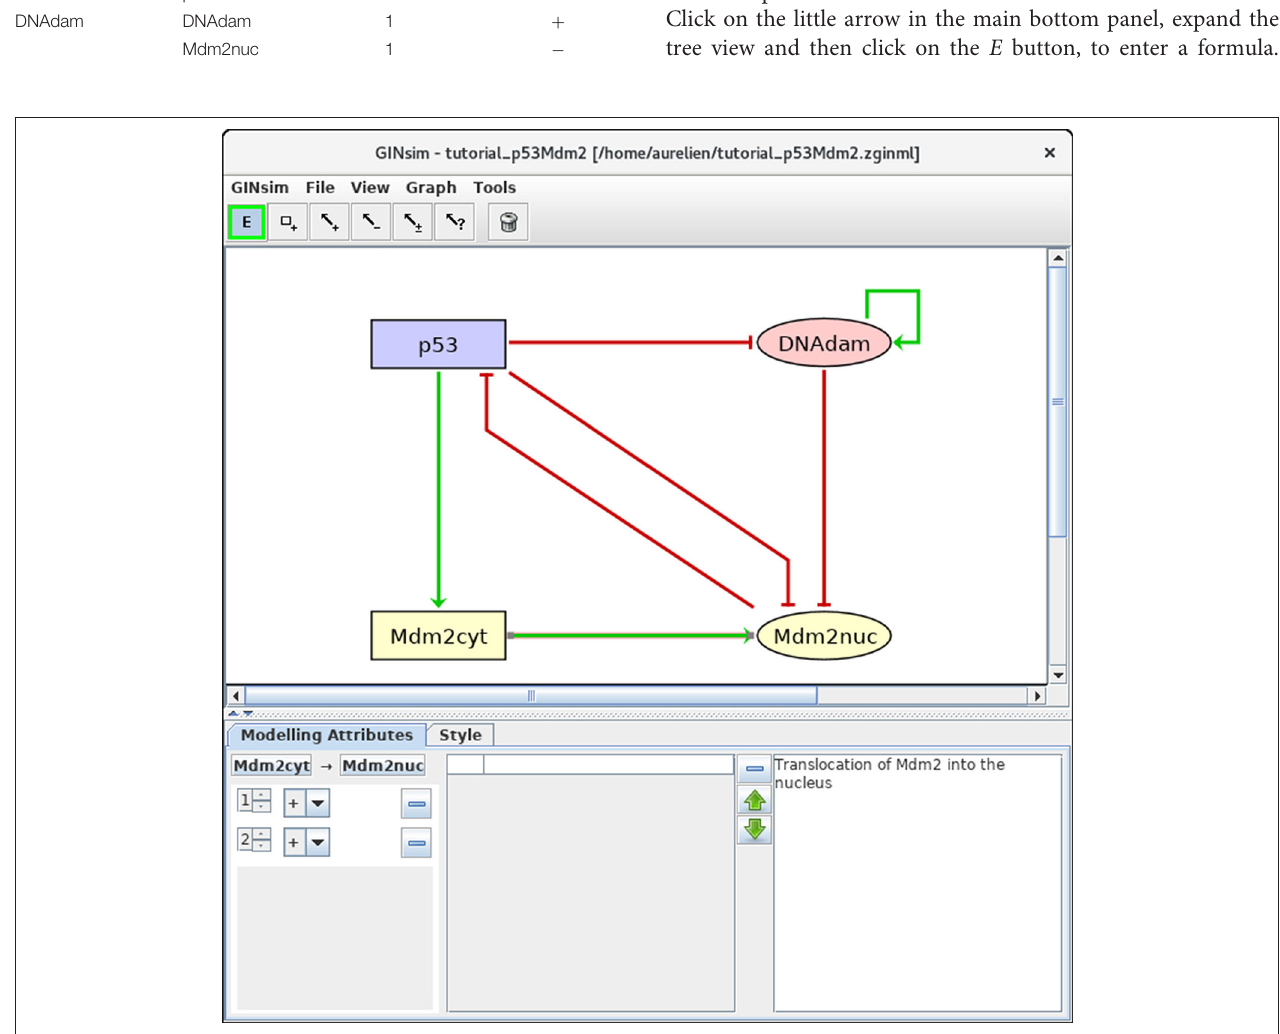
FIGURE 3 | Regulatory arc management in GINsim. To add an arc, the corresponding arc button must be pushed (push twice to add several arcs in one go), allowing the drawing of an arc between a source node and its target. Once an arc has been defined, it can be further edited by selecting it after locking the E button. The sign and threshold of the interaction(s) associated with an arc are defined within the Modeling Attributes tab, as shown here for the arc from Mdm2cyt onto Mdm2nuc. The additional interaction with threshold level 2 was created by clicking on the + button displayed when additional thresholds are available.